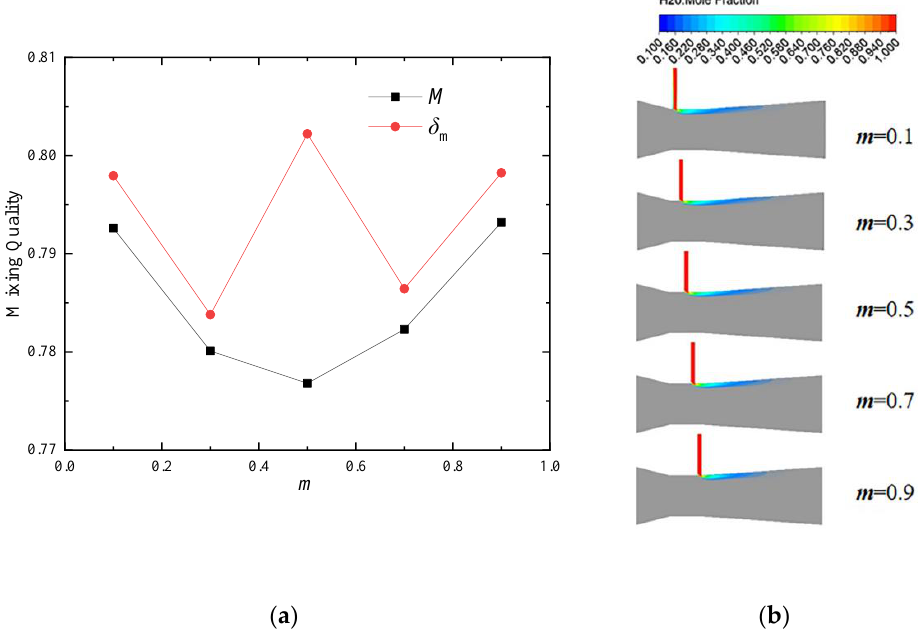
Figure 15. The effects of jetting position on ( a ) M and ( b ) concentration distribution of jetting flow in VTM.